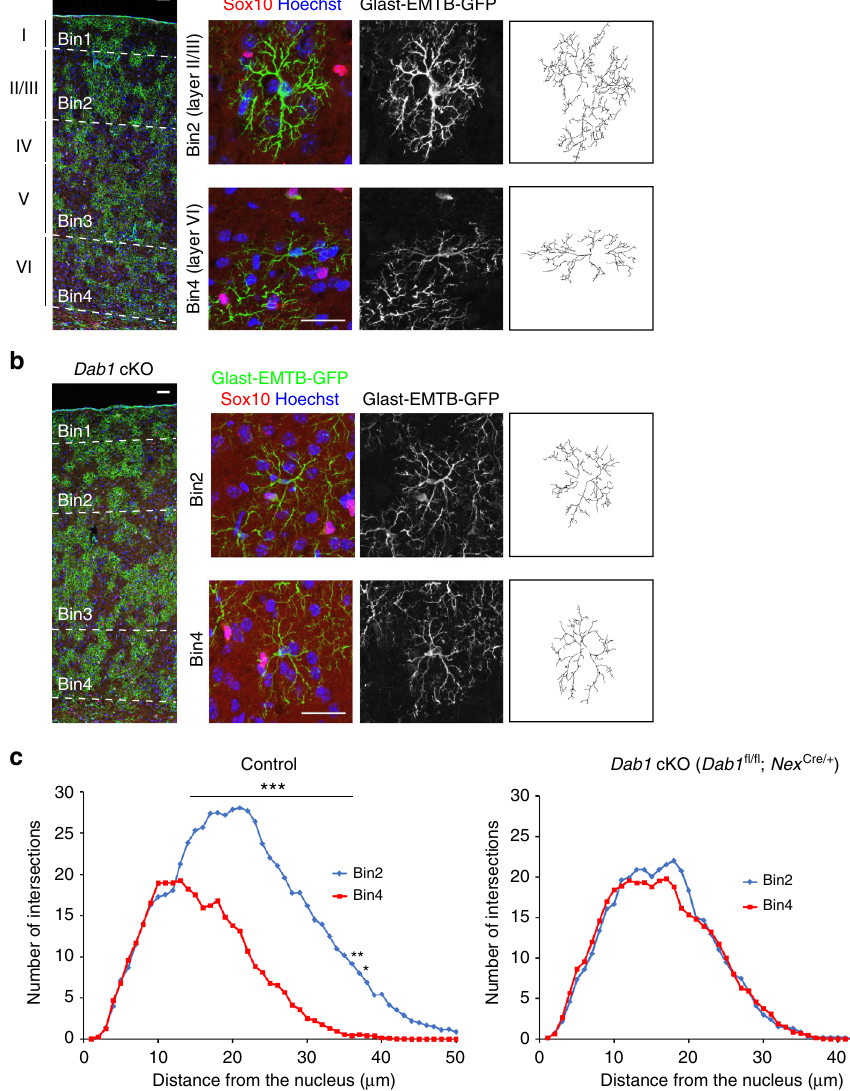
Fig. 8 Disruption of layer-speci fi c astrocyte arborization in Dab1 cKO mice. a , b Immuno fl uorescence staining for GFP and Sox10 in coronal sections of control (Glast-EMTB-GFP; Dab1 fl / fl or Glast-EMTB-GFP) ( a ) and Dab1 cKO (Glast-EMTB-GFP; Dab1 fl / fl ; Nex Cre/ + ) ( b ) mice at P30 (left panels). Nuclei were stained with Hoechst 33342. Scale bars, 50 μ m. Right panels show representative magni fi ed images of astrocytes and their traced processes in bin2 (layer II/III) and bin4 (layer VI). Scale bars, 25 μ m. c 2D Sholl analysis for microtubule structure of individual astrocytes in coronal brain sections. Astrocytes were randomly selected for analysis. Data are means for 15 cells in bin2 and 18 cells in bin4 for control mice and for 18 cells in bin2 and 17 cells in bin4 for Dab1 cKO mice. Three brains of each genotype were analyzed. * P < 0.05, ** P < 0.01, *** P < 0.001 (two-way ANOVA followed by Bonferroni ’ s